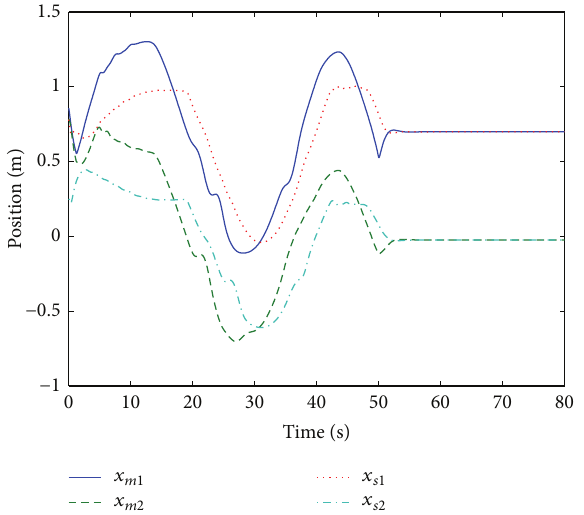
Figure5:Thepositionsofthemasterandtheslaveintaskspacewith adaptive regulator.